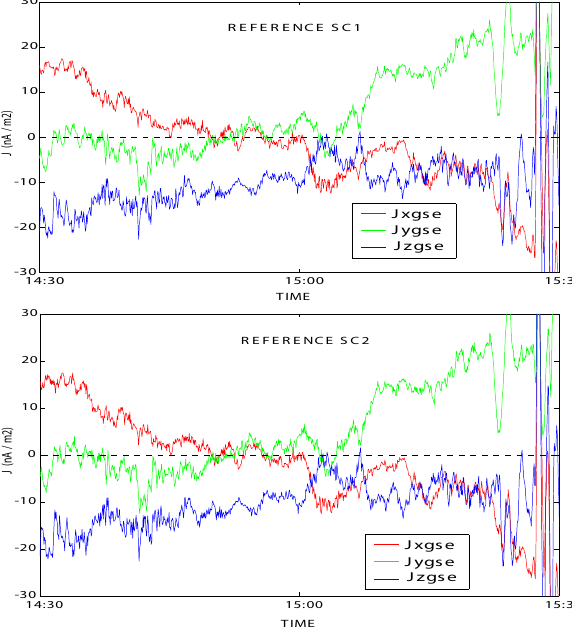
Fig. 2. Current density (in the GSE coordinate system) for the 13 April 2002 perigee pass, as computed using two different spacecraft of reference: SC1 (upper panel) and SC2 (lower